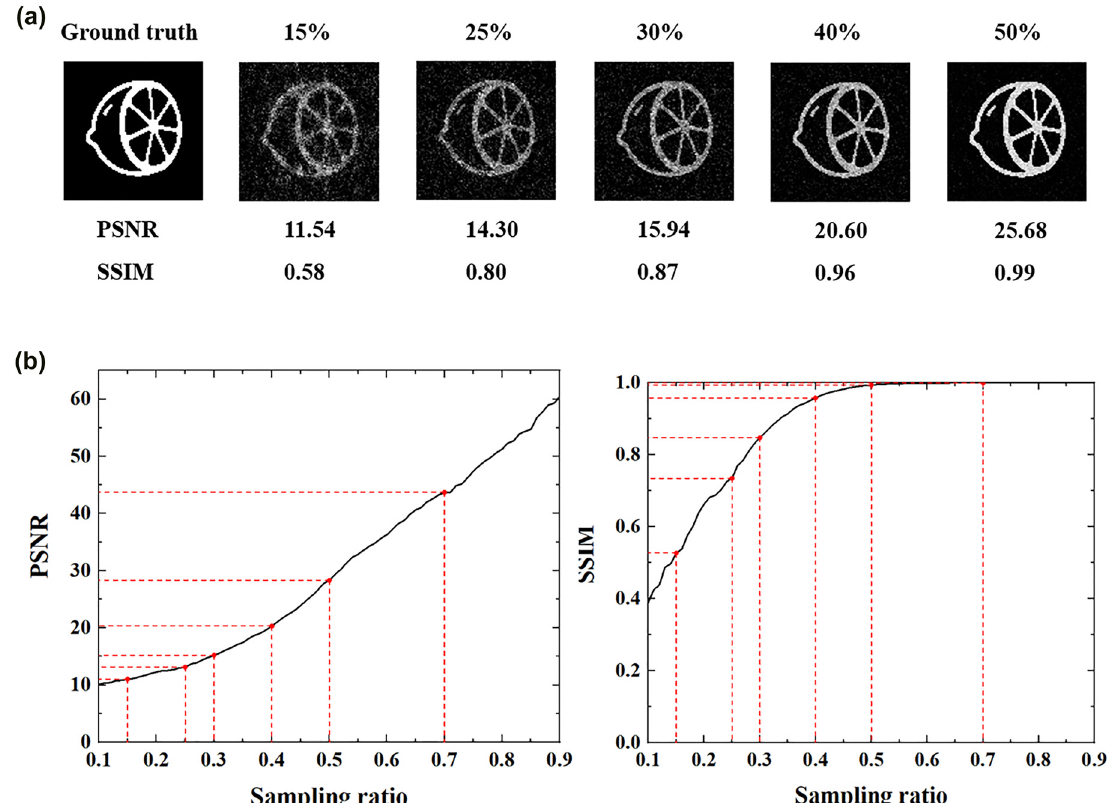
Figure 4: Simulation results at different sampling ratio by using angular spectrum propagation method. (a) Image reconstruction results and its evaluation index with sampling ratios of 15, 25, 30, 40 and 50%. (b) The PSNR and SSIM line chart under different sampling